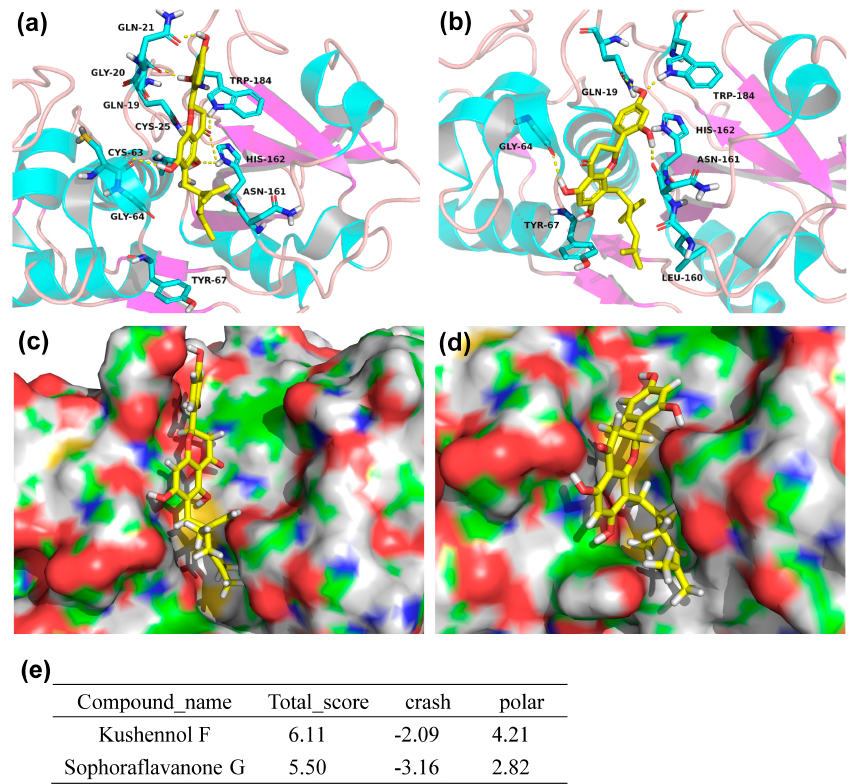
Figure 6. Predicted binding mode of KF and SG to the active site of Ctsk (PDB entry: 3KWZ). The structures of compounds were represented in stick model with color (yellow: carbon atom, red: oxgen atom and white: hydrogen atom). The binding mode of KF ( a ) and SG ( b ) in the active site of Ctsk. The protein was shown in the cartoon representation, the key residues in the active site were also represented as stick model with color (blue, red, and gray), the yellow dashed line denoted protein-ligand H-bonding interactions; The docking pose of KF ( c ) and SG ( d ) located in active site of Ctsk. The protein was illustrated by a solid surface; ( e ) The Docking Scores as acquired by Surflex-dock.